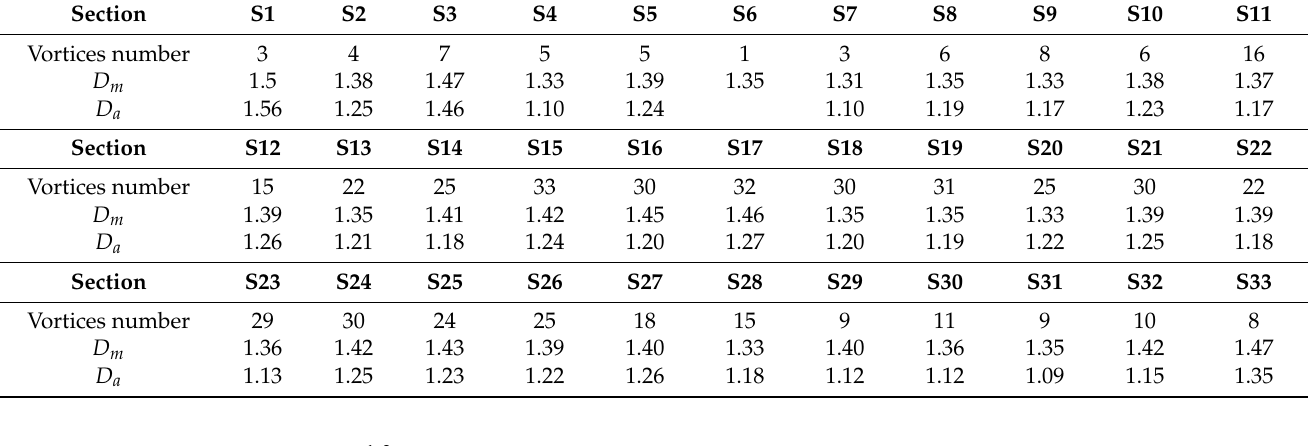
Table 3. Main vortex fractal dimension ( D m ) or average fractal dimension ( D a ) of vortex rope on each section.